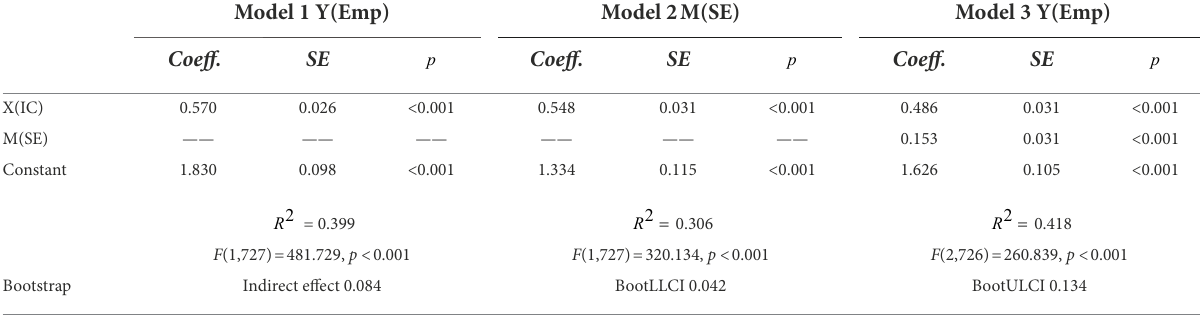
TABLE 6 Mediating effect of innovation capability on